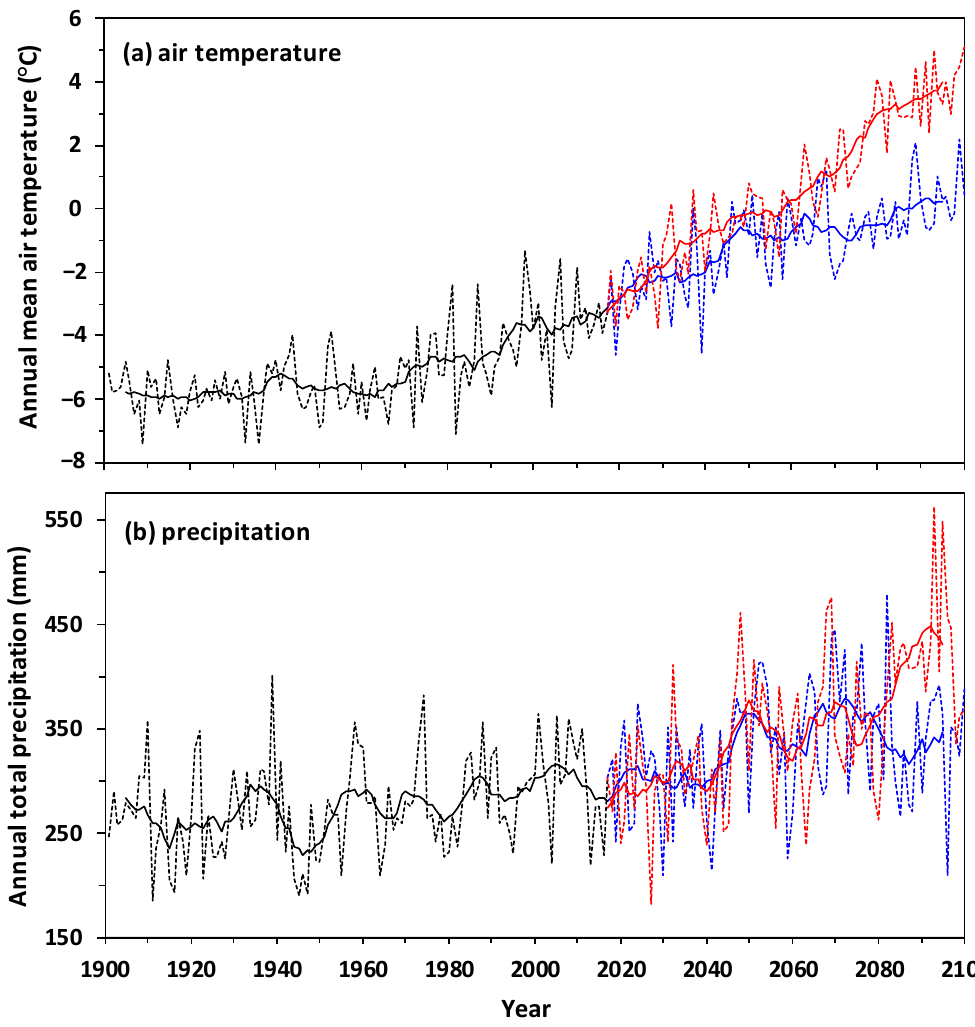
Figure 1. ( a ) Air temperature and ( b ) precipitation generated by Met1km for a grid at Yellowknife, Northwest Territories (62.4540 °N, 114.3718 °W). Black curves are for the historical period (1901–2017), blue and red curves are for future scenarios under RCP 4.5 and 8.5, respectively. The dash curves are annual values, and the bold curves are 10-year moving averages.